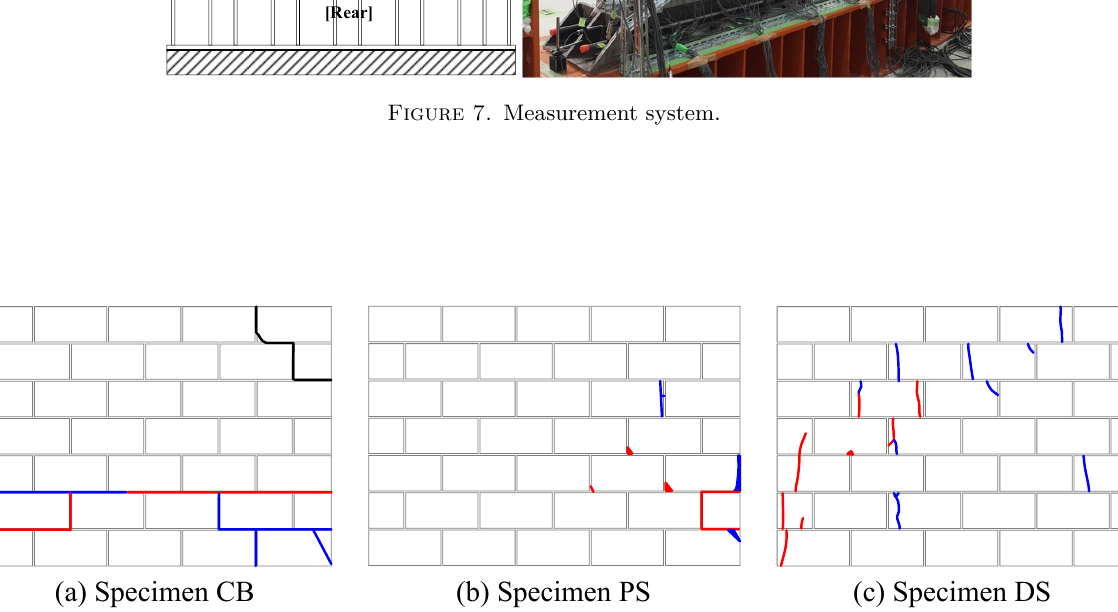
Figure 8. Final crack patterns (Blue: Positive dir., Red: Negative dir., Black: Initial